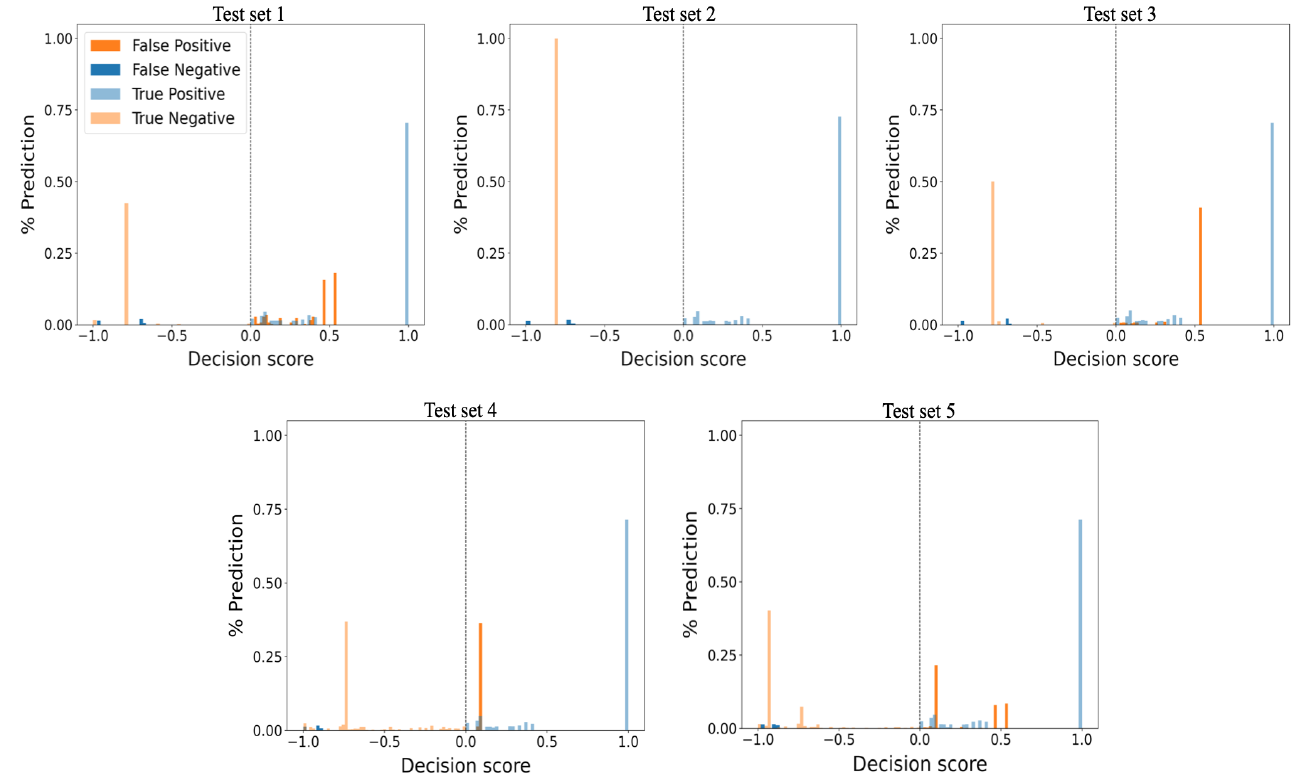
Figure 8. IF results of the normalized TP, TN, FP, and FN values on test sets